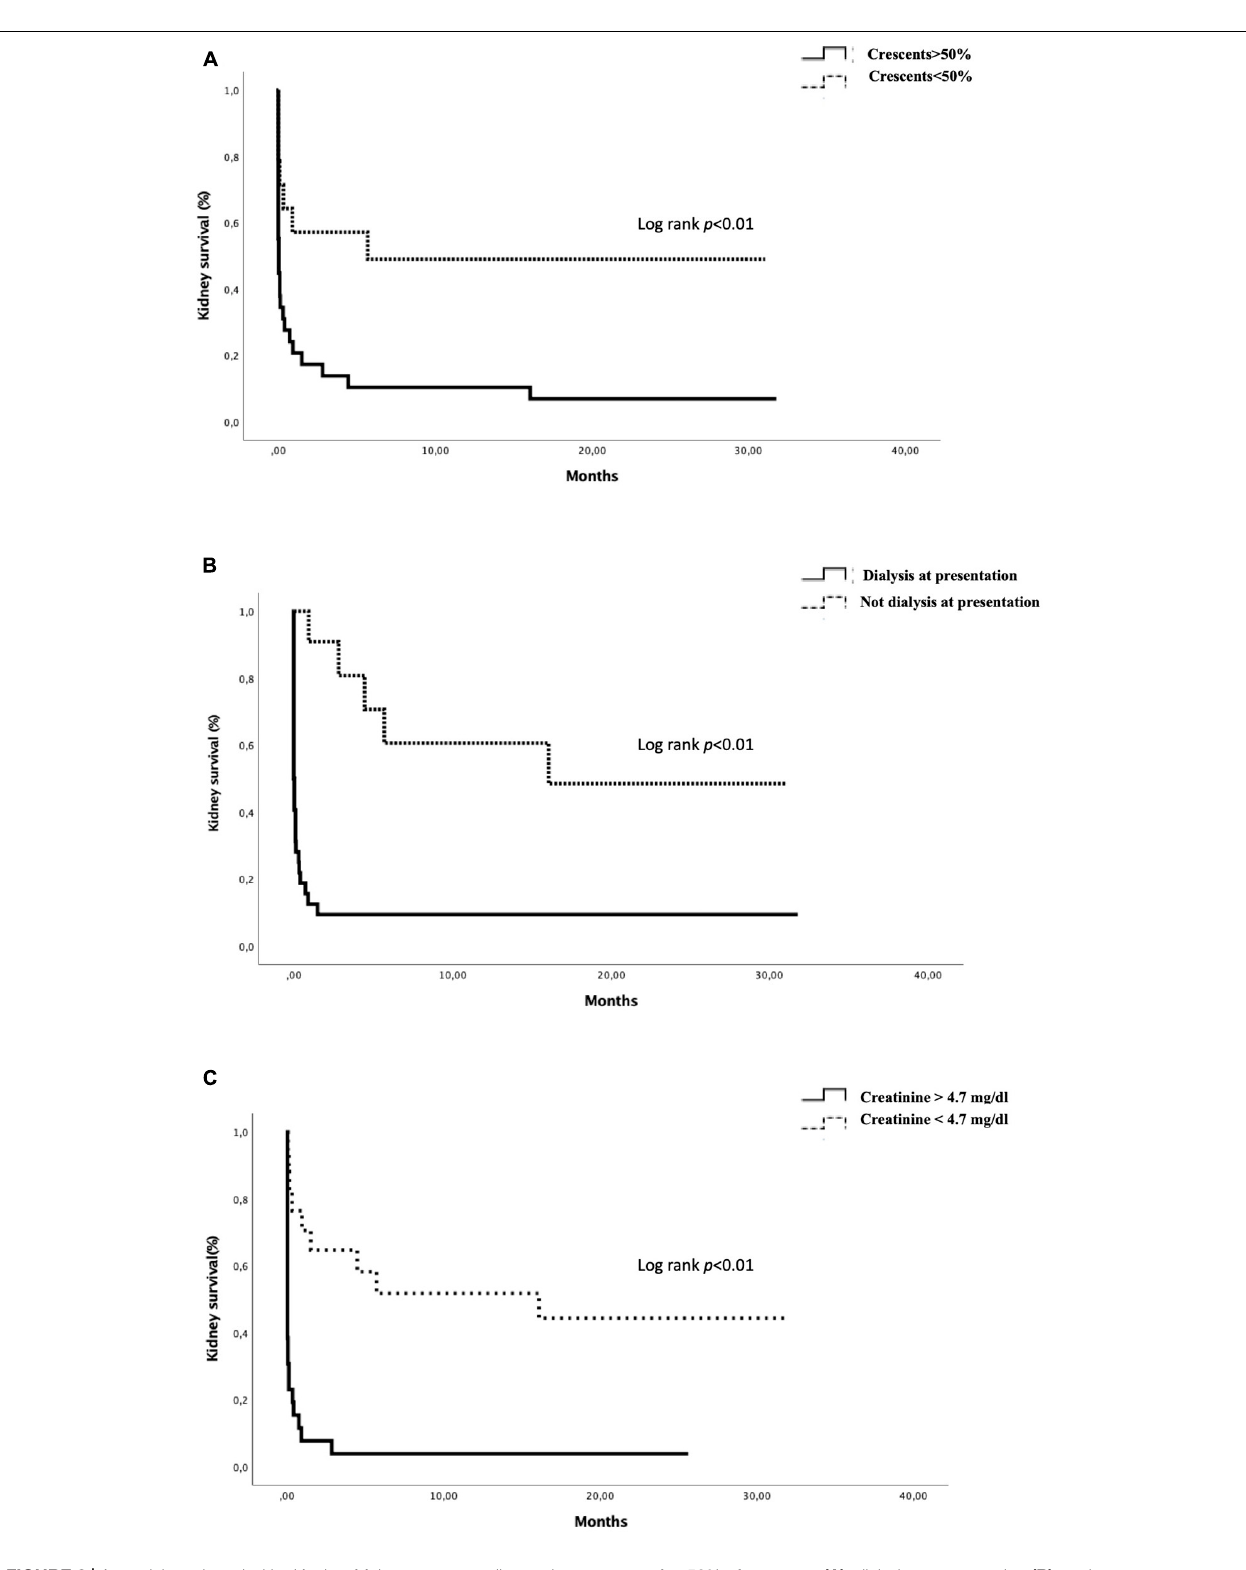
Frontiers in Medicine |